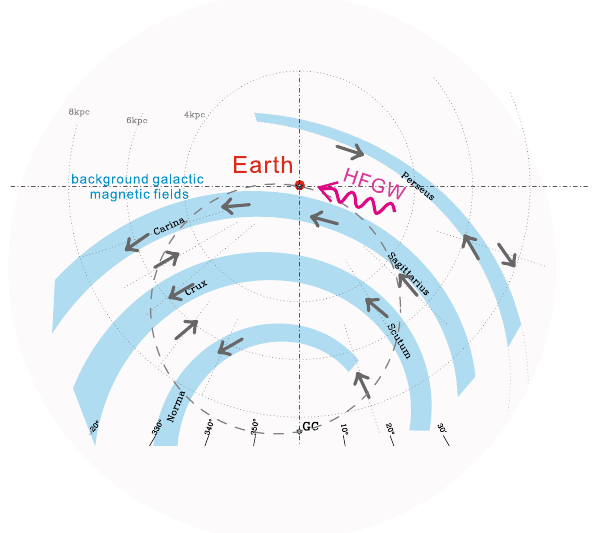
Fig. 5 The spatial scale of distribution for the background magnetic fields in the Milky Way reaches up to ∼ thousand light-years long [52, 53,56], and the magnetic fields have a stable strength and direction in the scale. Thus any HFGWs passing through the background magnetic fieldwouldgenerateasignificantspace-accumulationeffectintheEarth region. This figure is made based on some materials of Refs.